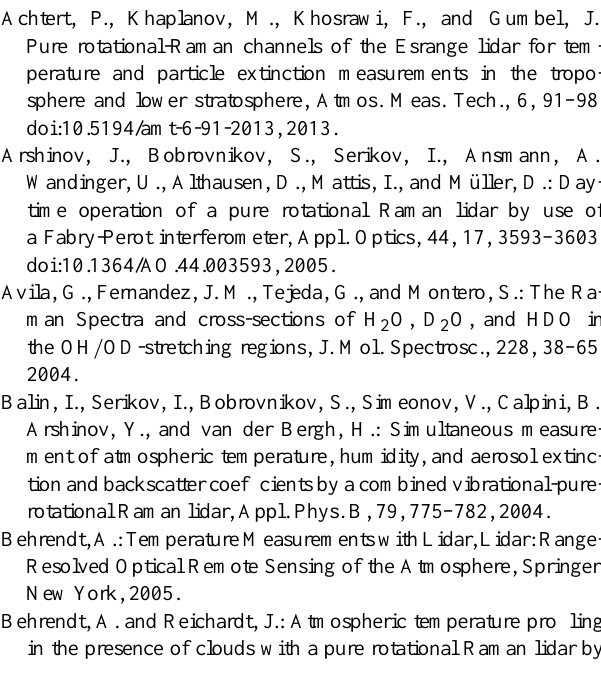
quired profiles and projected to the vertical for the compar- ison. A positive gradient is present below 100 m in the lidar profile, whereas in the radiosonde profile it is shifted by 50 m to higher altitudes. The lidar profile is corrected for the alti- tude of the surrounding terrain. Whereas the altitudes of the inversion differ, the slope of the temperature profiles is iden- tical. So we conclude that the observations indeed reveal dif- ferences of the temperature inversion profile of the nocturnal boundary